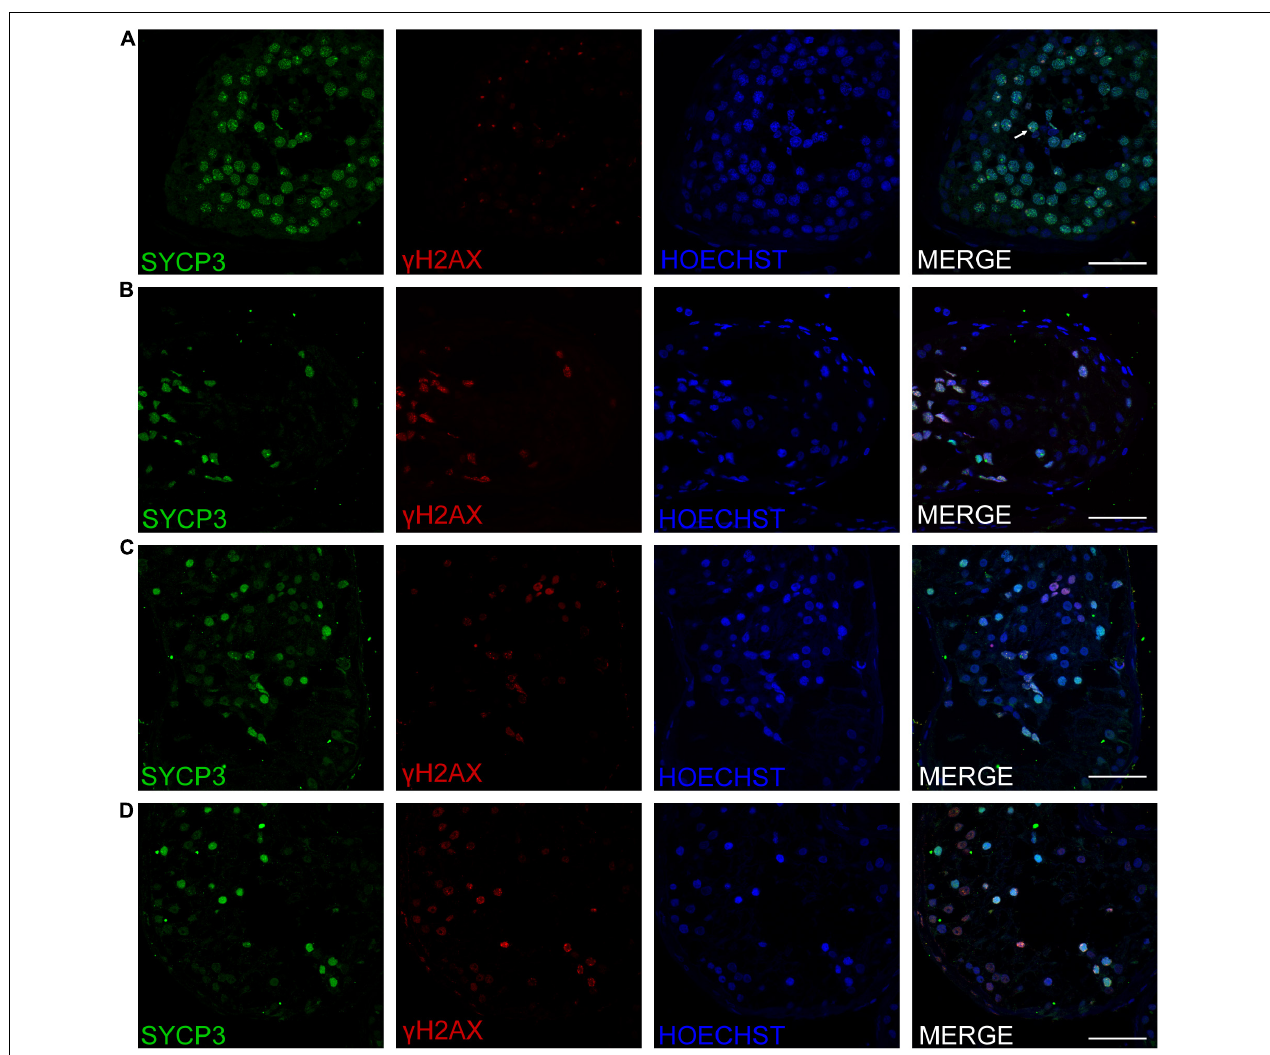
FIGURE 4 | Expression of SYCP3 and γ H2AX in the testis of affected patients and a patient with OA as positive control. Immunohistochemical staining showed the expression of SYCP3 (green) and γ H2AX (red) in the testis of the patient with OA (positive control) (A) , the P5648 (B) , the P6825 (C) , 7583 (D) . Scale bars = 50 µ m in panels (A–D) . The arrow indicates the XY body in the spermatocytes in the